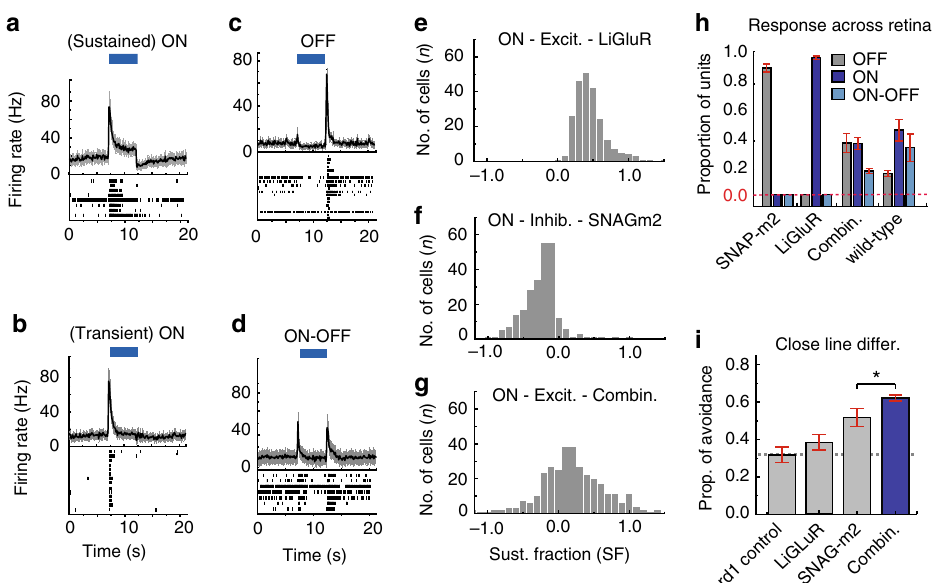
Fig. 5 Assessment and behavioral function with restoration using co-expression of LiGluR with SNAG-mGluR2. a – d (top) Averaged response of RGC ON- sustained ( a ), ON transient ( b ), OFF ( c ), ON – OFF ( d ) responding population within the same retina expressing both SNAG-mGluR2 and LiGluR. Standard errors in gray. (Bottom) Averaged raster plot of individual units for 10 fl ashes of blue light. e – g Histograms showing distribution across RGC population in sustained fraction of the light response, calculated as the fi ring rate at the end of illumination divided by the peak- fi ring rate for each cell (larger peak response selected between initial response at the start of illumination and the rebound OFF response). N = 3 retinas per condition: LiGluR alone ( n = 227); f ), SNAG-mGluR2 alone ( n = 246) and SNAP-mGluR2 + LiGluR co-expression ( n = 222). h Proportion of units identi fi ed in retinas that display ON (blue), OFF (gray) and ON-OFF (light blue) response to full fi eld illumination. Retinas expressing SNAP-mGluR2 (Left), LiGluR (Middle-left), both SNAP-mGluR2 and LiGluR (Middle-right), or wt ( N = 3 retinas per condition). Error bars represent S.D., red dashed line denotes zero, emphasizing the absence of ON and ON-OFF responses in SNAG-mGluR2 alone and of OFF and ON-OFF responses in LiGluR alone. i Learned pattern discrimination behavior using paring of parallel bars with distances of 1 vs. 3 cm. Plotted mean proportion of time spent on non-aversive side (avoiding) the pattern associated with the shock for rd1 co-expressing LiGluR + SNAG-mGluR2 (Blue) ( N = 18). rd1 untreated control (Gray-Left) ( n = 12), LiGluR (Gray-Middle) ( N = 15), rd1- SNAP-mGluR2 (Gray-right) ( N = 18), reproduced from Fig. 4h for reference and comparison. In addition, proportion of success was also calculated (Supplementary Fig. 5 b, d – g and Table 3). Light intensity 25 – 50 mWcm − 2 , BGAG 12,460 labeling at 50 μ M. N = retina or mice per condition, n = total units/cells. All units refer to sorted cells. All animals received 2 μ L intravitreal injection of 1 μ M BGAG 12,460 in each eye and assayed following 24 h recovery. Display of 472 nm light equaled 5 mW cm 2 at decision point. Statistical signi fi cance was assessed using Student ’ s two-tailed t- test: * p < 0.05 ( i